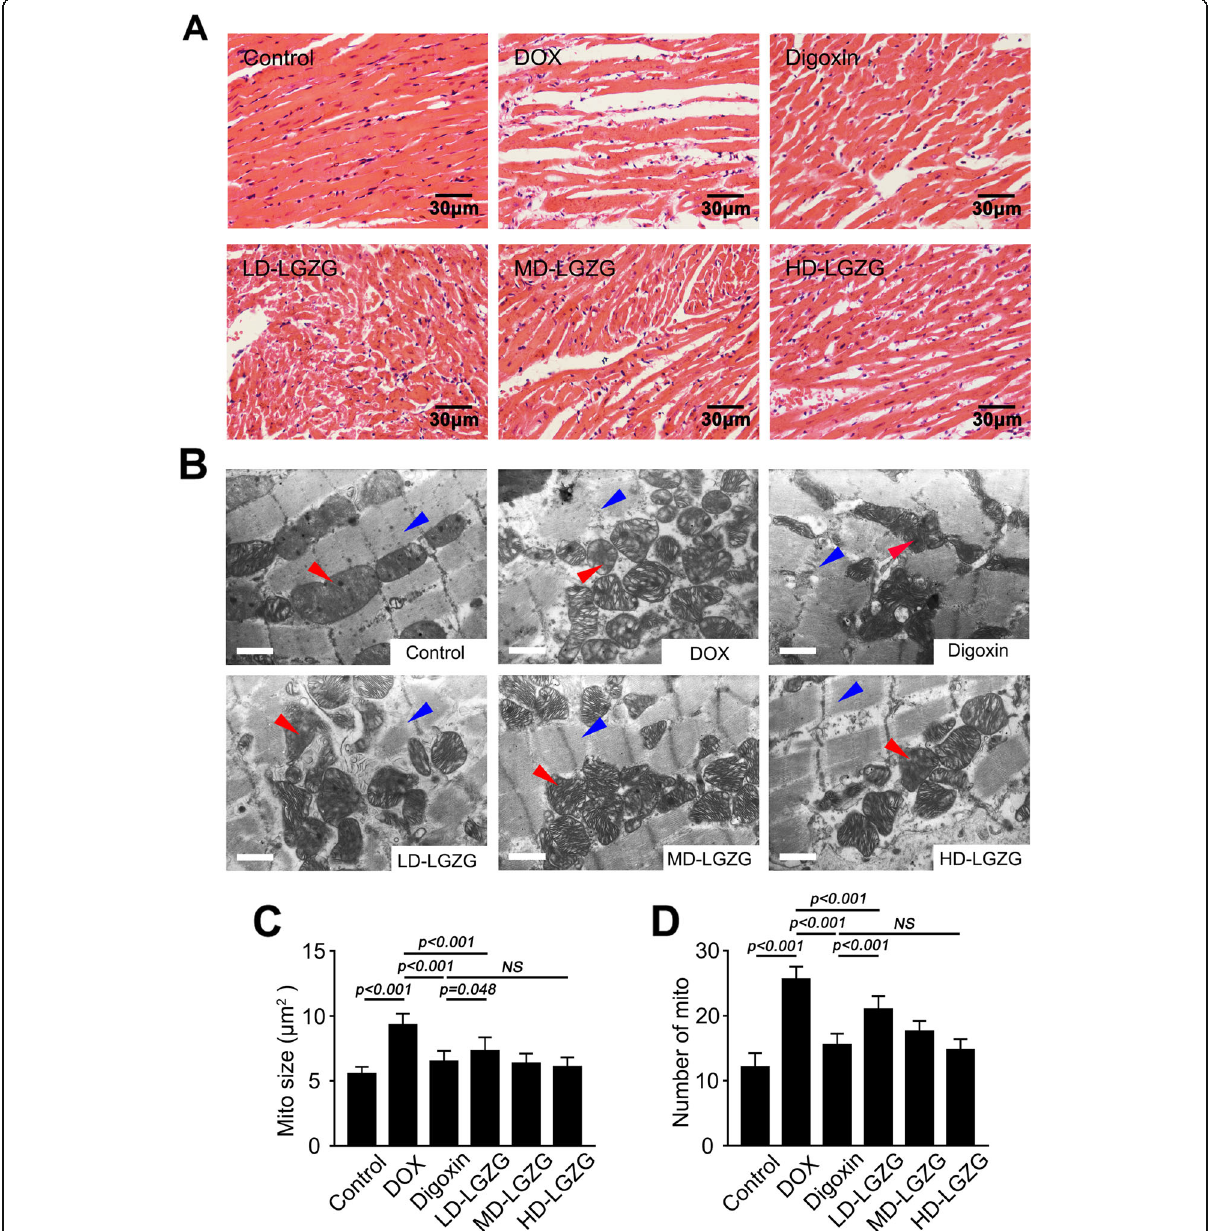
Fig. 3 LGZG attenuated the changes in myocardial morphology and ultrastructure. ( a ) Representative images of H&E-stained cardiac tissue. ( b ) Representative TEM images of cardiac tissue (scale bar, 1 μ m). Red arrows, mitochondria; blue arrows, myofibrils. Intermyofibrillar mitochondrial size and number are shown in ( c ) and ( d ). Data are mean ± SEM, n = 8. NS, not